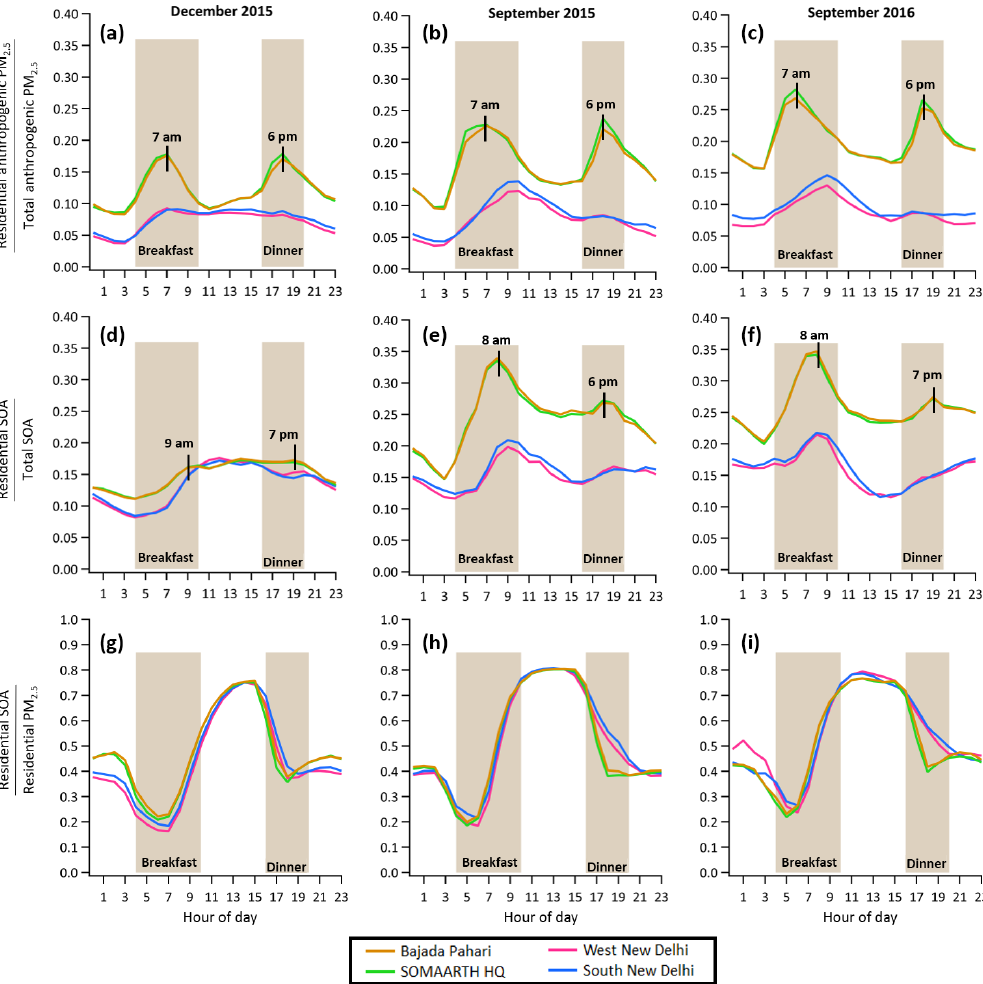
(a–c) , Residential SOA Figure 11. Average diurnal Residential anthropogenic PM 2 . 5 (d–f) , and Residential SOA (g–i) . Bajada Pahari is shown in Total anthropogenic PM 2 . 5 Total SOA Residential PM 2 . 5 yellow, SOMAARTH HQ in green, West New Delhi in pink, and South New Delhi in blue. Shading indicates mealtimes. Residential PM is calculated as the difference in predictions from the nonresidential and total emission scenario and averaged over simulation durations (Table 7). Computations were carried out at 4km resolution. Statistics are shown in Table